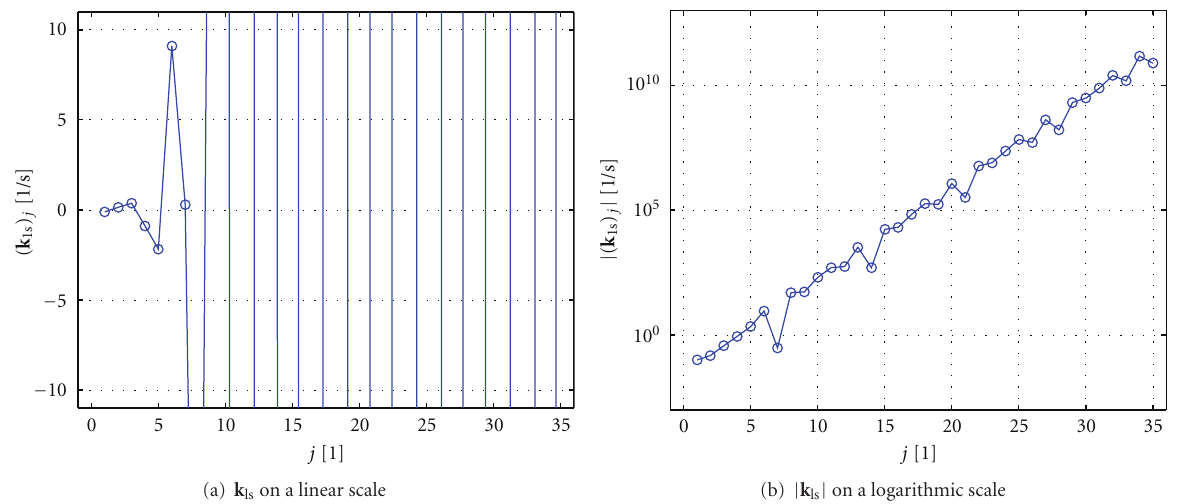
Figure 7: Least-squares solution vector k ls of (38) using the example data from Figure 6. ( k ls ) j denotes the j th entry of the vector k ls . The plot shown in (a) illustrates the strong oscillations of k ls . The plot given in (b) shows the amplitude | k ls | of this function on a logarithmic